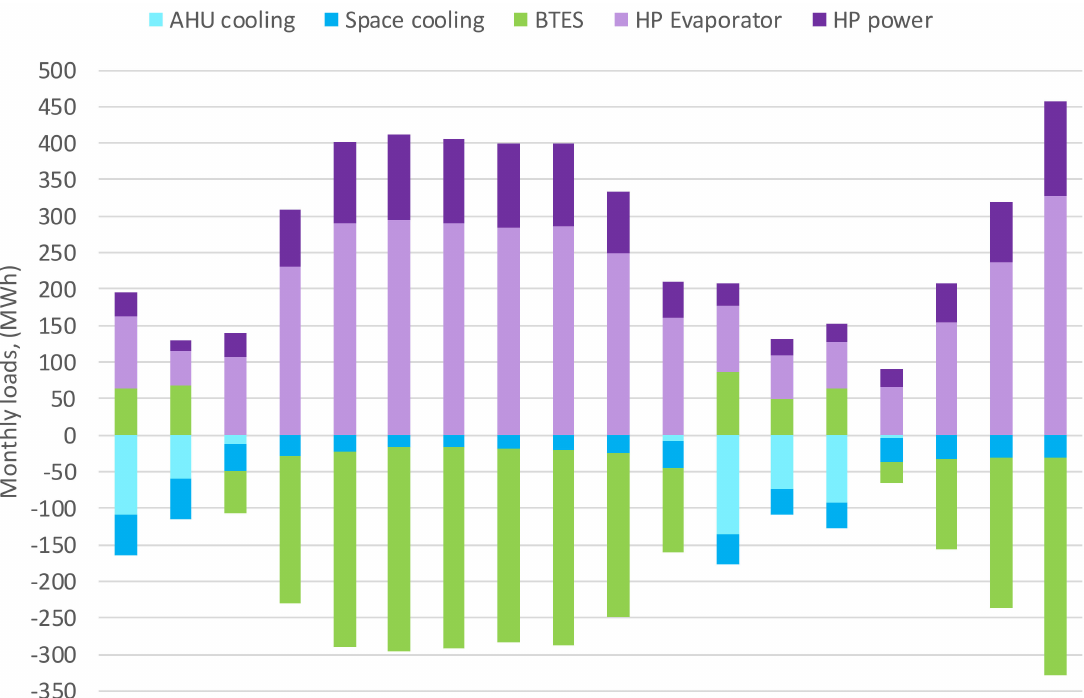
Figure 7. Monthly loads on the evaporator